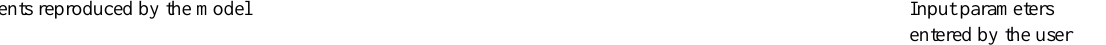
Table 1. Input parameters used to reproduce the first case study. Left column represents the statements reproduced by the model with the same format as in the simulation. Right column represents the input parameters entered by the